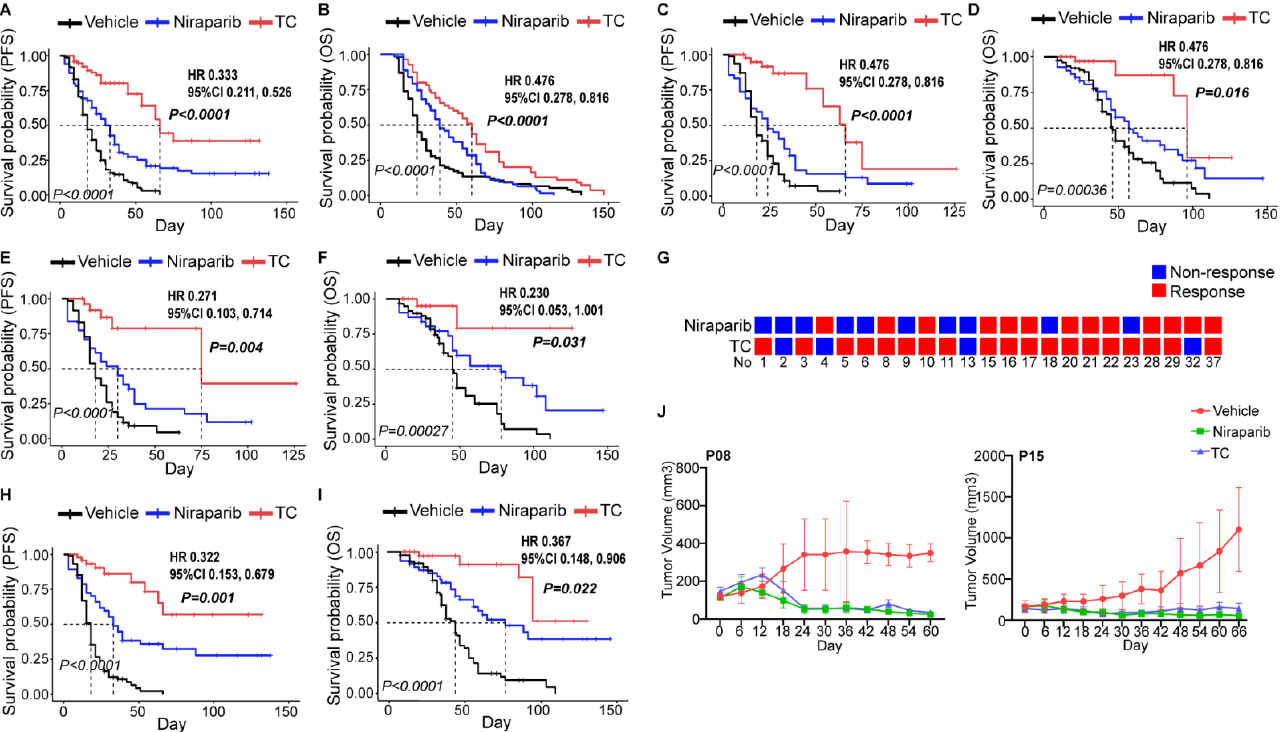
Figure 4. Comparing the efficacies of niraparib and TC in PDX. The survival outcomes of the control, niraparib, and TC chemotherapy groups in PDXs of naive patients ( A , B ), the HRD+ subgroup ( C , D ), or the BRCA mutation subgroup ( E , F ) were analyzed. ( G ) Results of the niraparib and TC susceptibility tests evaluated by PDXs in 23 patients. ( H , I ). The survival outcomes of the control, niraparib, and TC chemotherapy groups in patients who simultaneously responded to niraparib and TC. ( J ) Tumor volume changes due to the vehicle (red), niraparib (green), and TC (blue) treatments in 2 patients (P08 and P15) who were responsive to niraparib but not TC. The italic p value in each Kaplan‒Meier survival curve figure indicates the comparison of those three groups, and the p value (bold and italic), hazard ratio (HR), and 95% confidence interval (CI) represent the comparison between the niraparib and TC groups. TC, paclitaxel and carboplatin chemotherapy; PFS, progression- free survival; OS, overall survival.